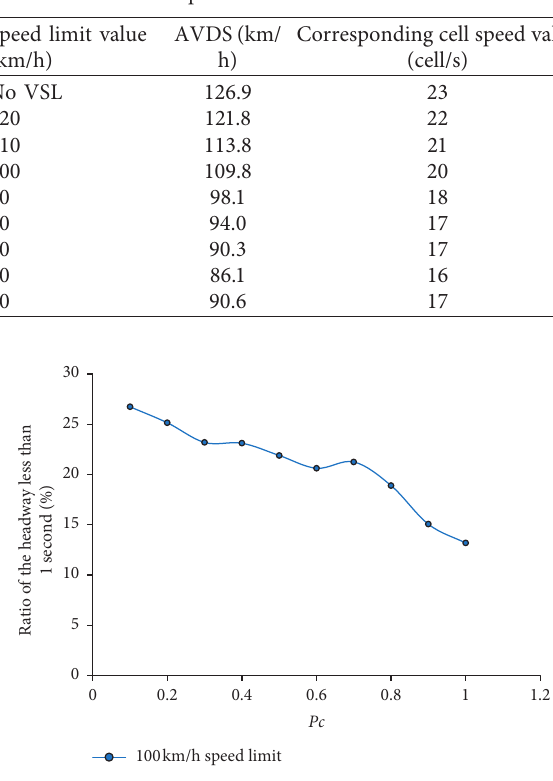
Table 3: Variable speed limit AVDS values of the left lane.